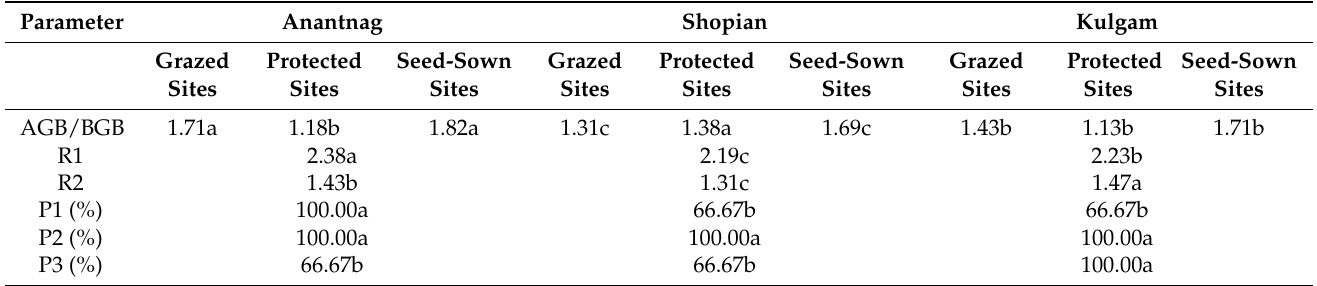
Table 5. Comparison between southern Kashmir districts in terms of biomass production.